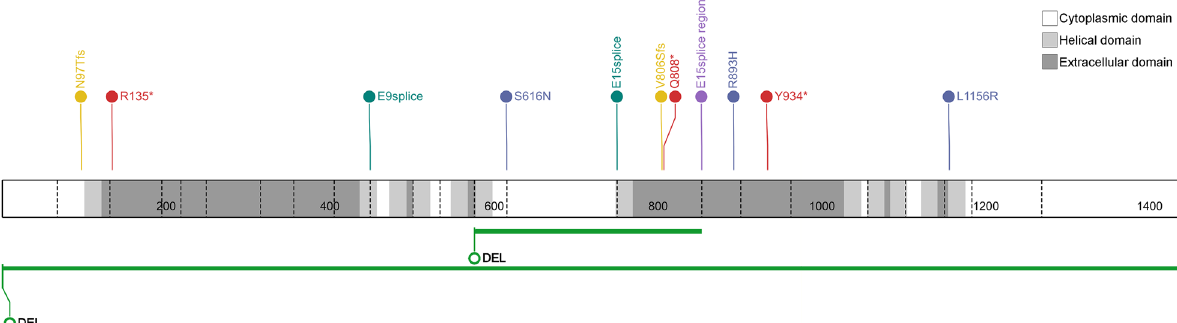
Figure 2. PTCH1 variant distribution of 15 Korean patients with NBCCS along with the patched-1 protein. DEL deletion, red nonsense variant, yellow frameshift variant, green large deletion, dark green splice site variant, blue missense variant, purple splice region